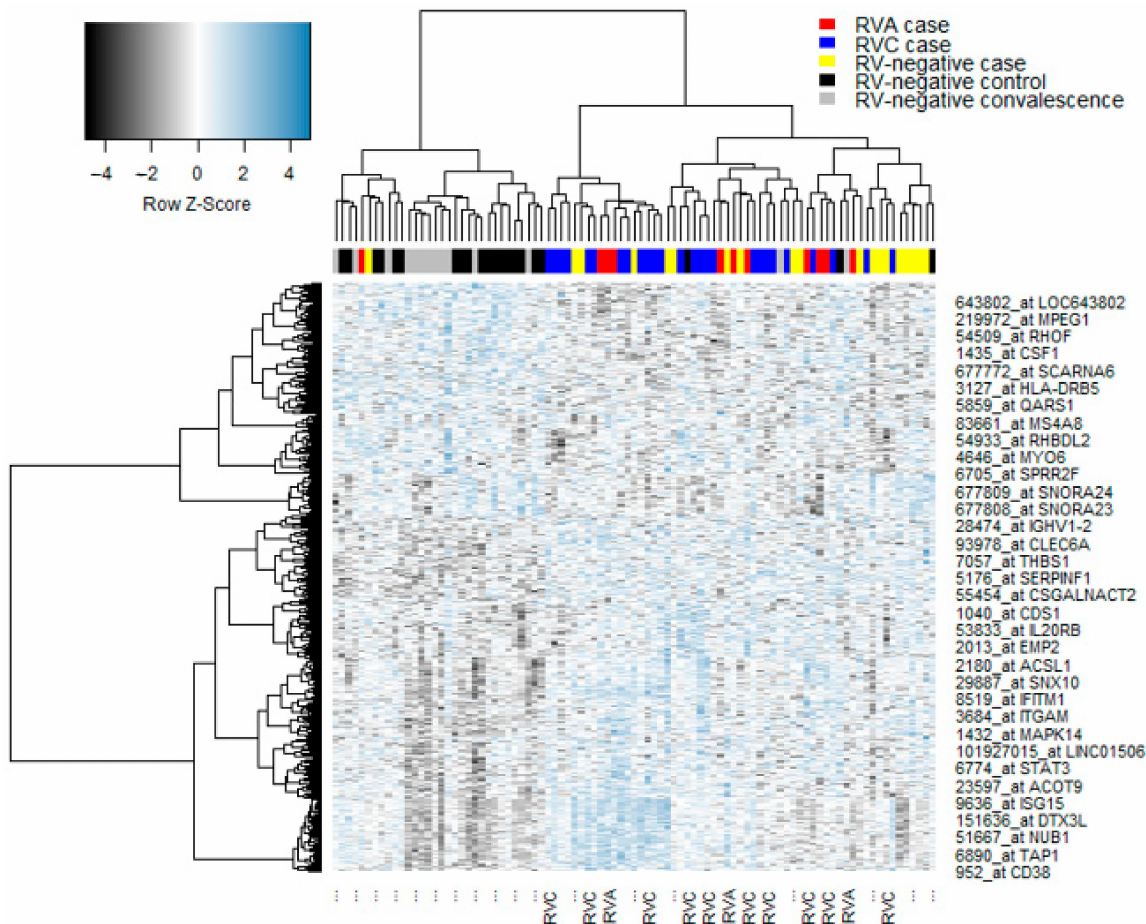
Figure 1. Gene expression was profiled in nasal swab samples from children with acute asthma/wheeze or controls. Differentially expressed genes were identified in children with acute wheezing, convalescence or controls, stratified by RV infection status. The data were transformed to Z-scores, analyzed by hierarchical clustering and visualized as a